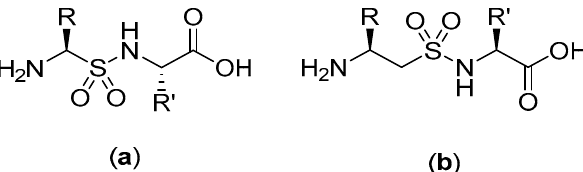
Figure 25. ( a ) Structure of α -peptidosulfonamide- α -peptide hybrid. ( b ) Structure of β -aminosulfonamide- α -peptide hybrid.